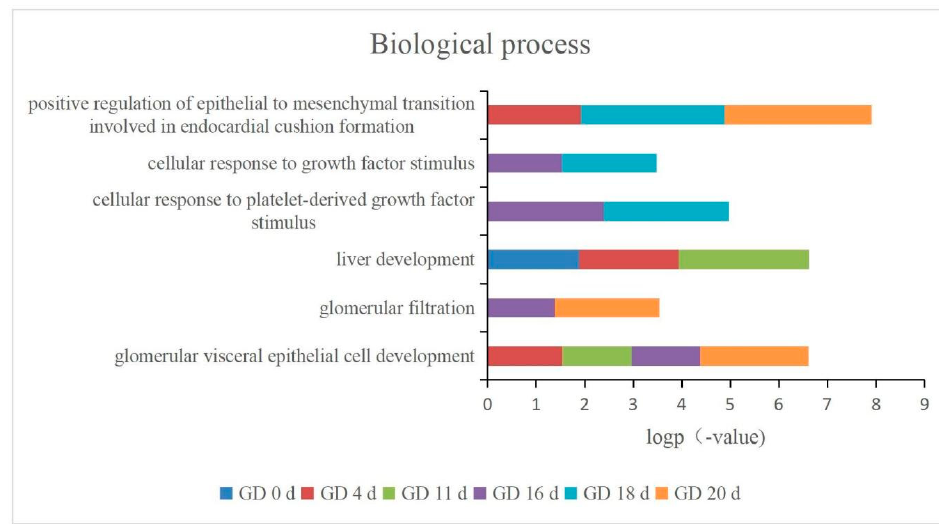
Figure 7. Changes in pathways related to organ development over